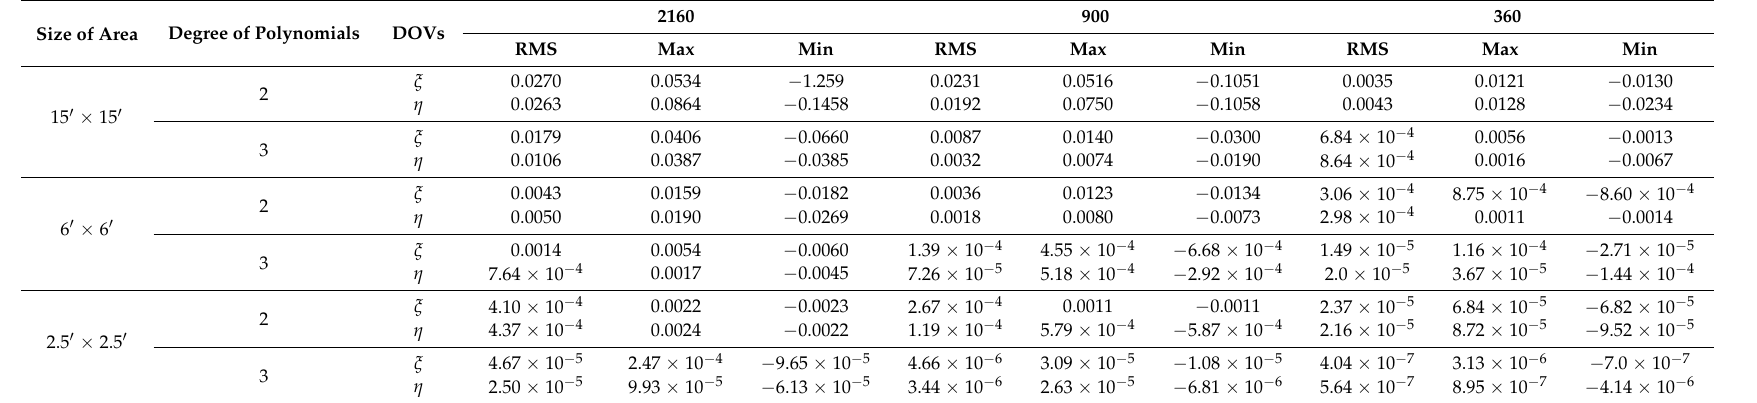
Table 3. Numerical results of polynomial fitting in the North China Plain.